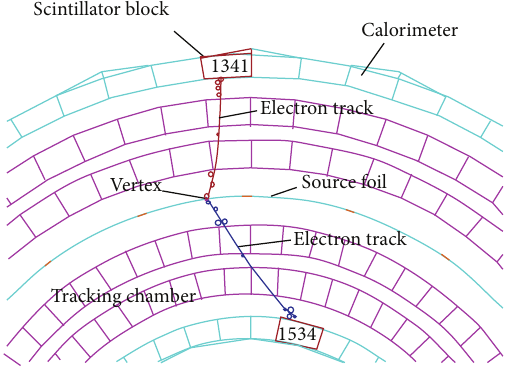
Figure 5: The figure shows how a 𝛽𝛽(0 ] ) decay candidate event would appear in the NEMO3 detector